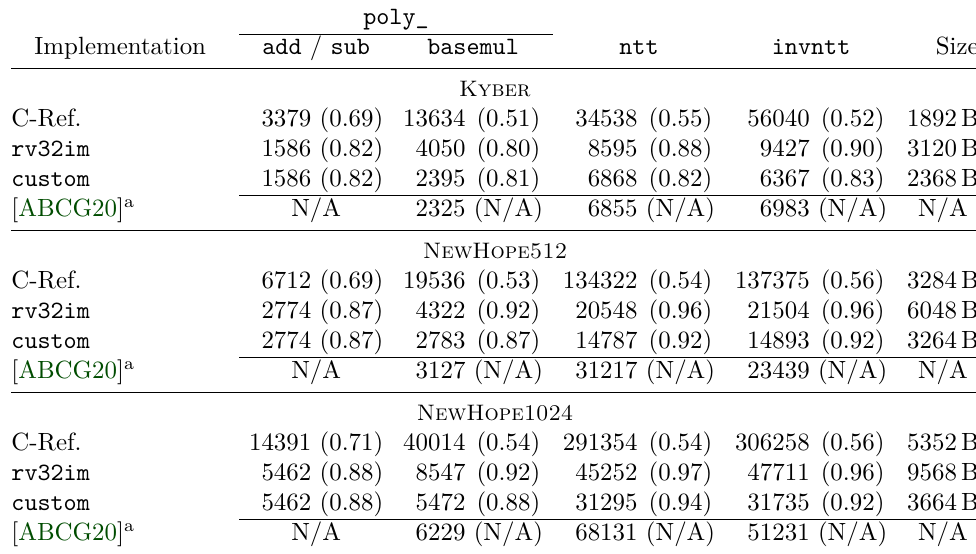
Table 3: Number of cycles and executed instructions per cycle (in parenthesis) for a single polynomial operation of addition, subtraction, multiplication (element-wise in NTT domain), and NTT as well as overall code size in